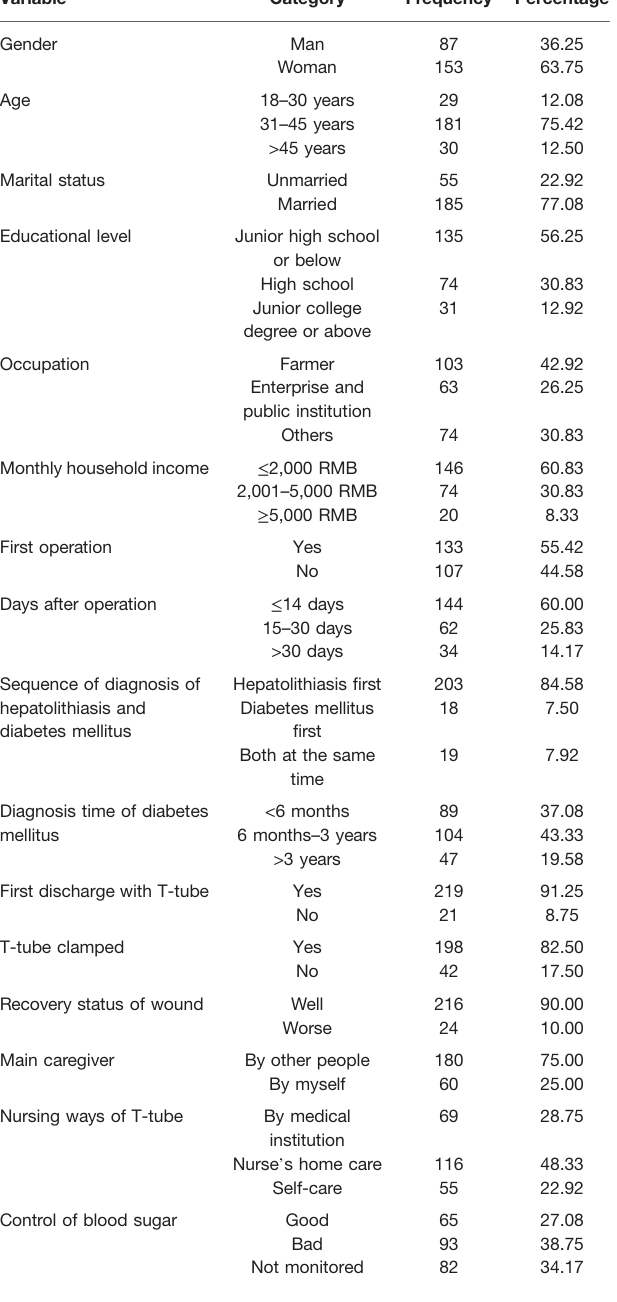
TABLE 1 | General information of research objects ( n =240,